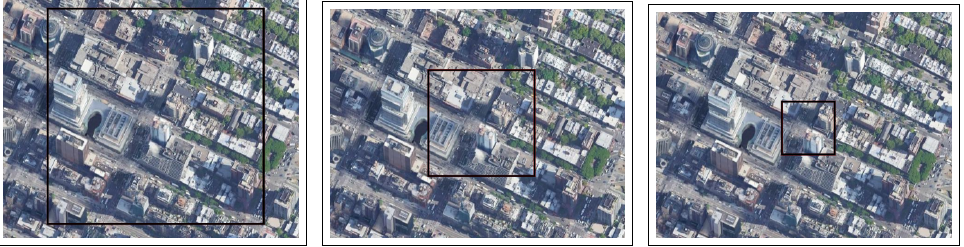
Figure 6. Location #3: 200 m (in the left image), 100 m (in the center image), 50 m (in the right image).